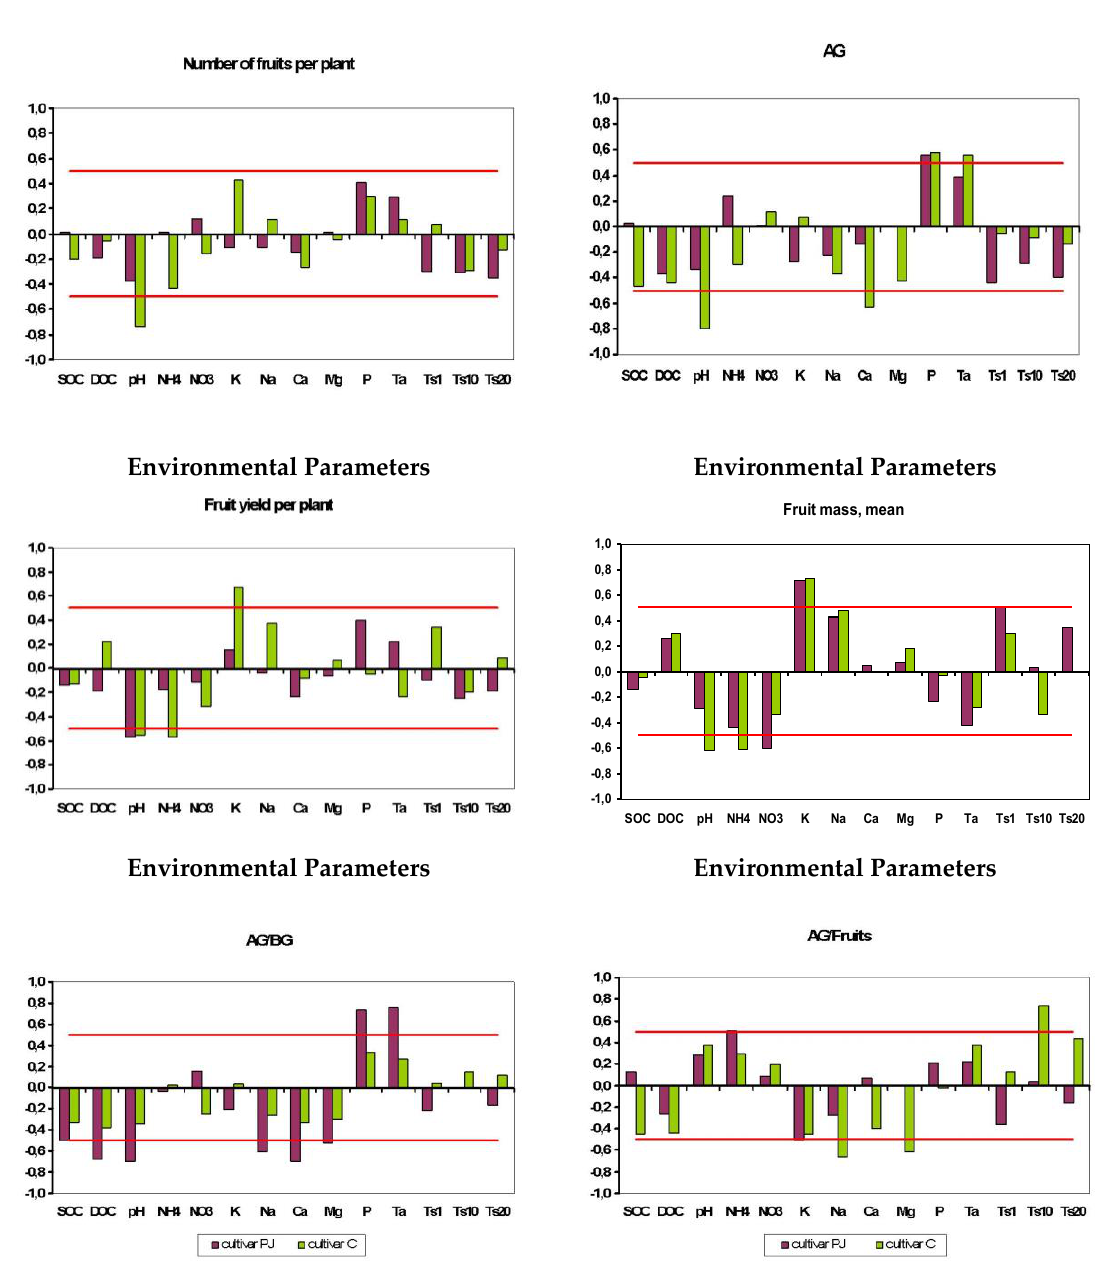
Figure 3. The correlation coefficients between Plum Jam (PJ) and Confectioner (C) husk tomato production characteristics, soil chemical properties, and soil and air temperature. Red lines indicate the levels of correlation coefficients, above or below which the correlation coefficients are statistically significant ( P ≤ 0.05). Environmental parameter abbreviations: SOC, soil organic carbon; DOC, dissolved organic carbon; NH 4 and NO 3 , exchangeable soil ammonium and nitrate, respectively; Ta, the sum of air temperature over the growing season; Ts1, Ts10, and Ts20, the sum of soil temperatures at a depth of 1, 10, and 20 cm over the growing season, respectively.